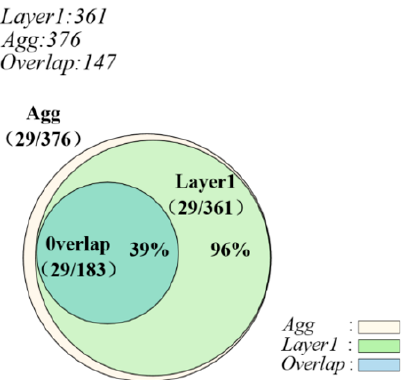
Figure 15. Distribution of overlapping edges between layer1, the aggregation layer and the overlap layer.